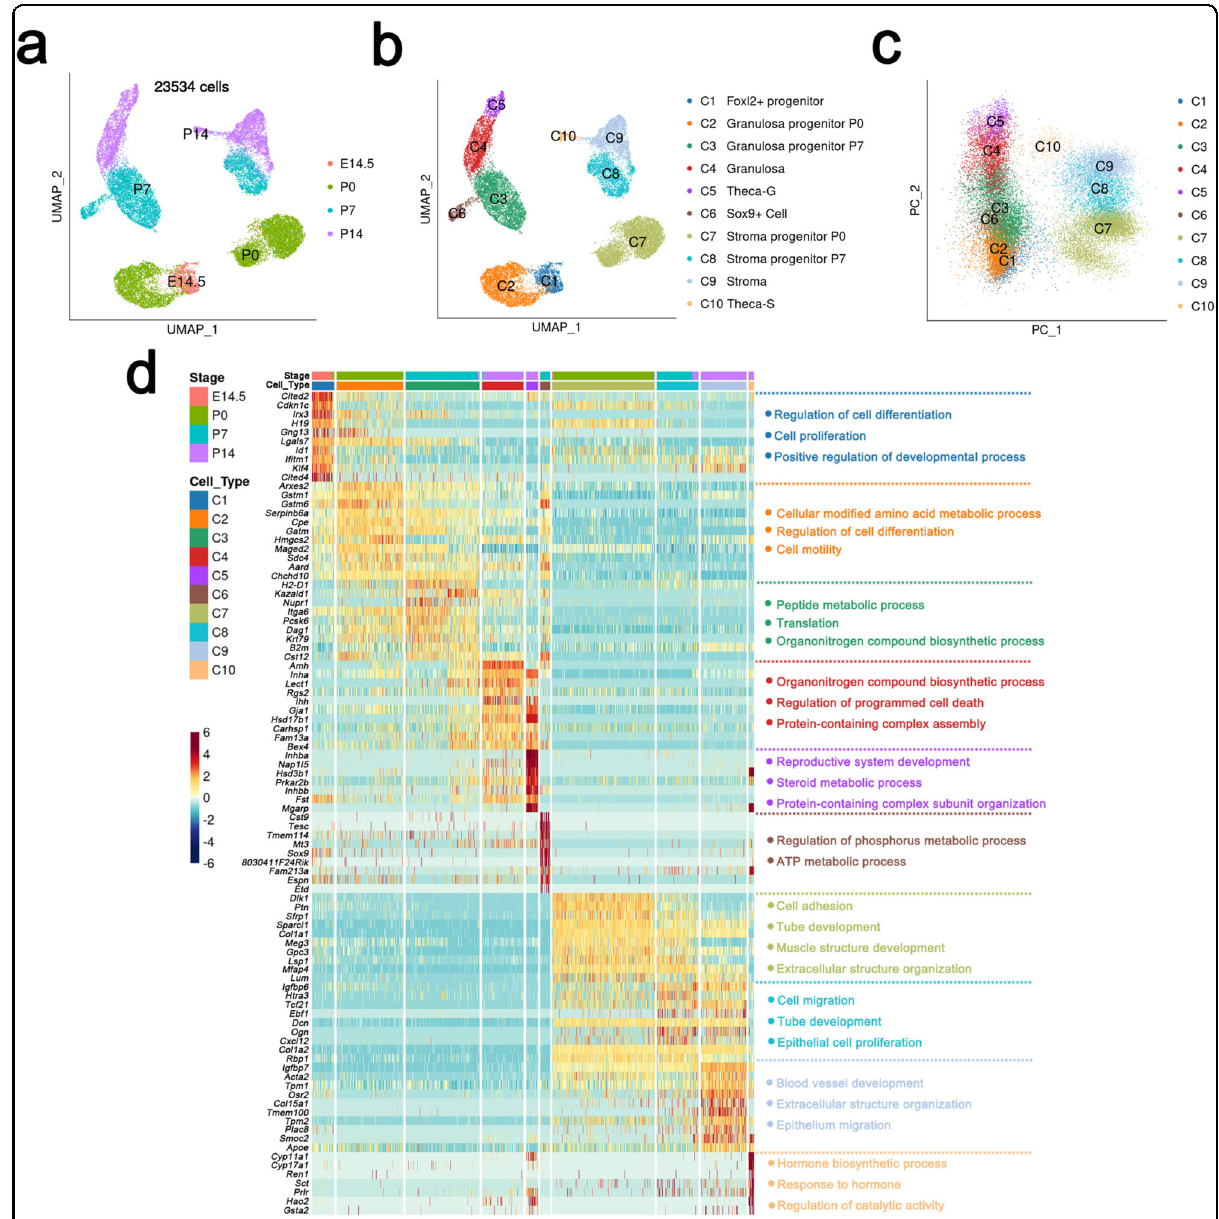
Fig. 3 Classi fi cation and Identi fi cation of progeny of Foxl2 -expressing cells during ovarian development. a Expression matrix-based Uniform manifold approximation and projection (UMAP) plot showed the fi ltered FOXL2 + progenitor-derived cells (23,534 cells). Cells were colored by time points of sample collection. b UMAP plot as shown in a , with cells colored by cell clusters after unsupervised clustering. c Expression matrix-based principle component (PC) plot of cell clusters in b . d Left, heatmap showing top ten highly expressed genes for each cell cluster shown in b , red color corresponded to high expression levels; blue color corresponded to low expression levels. Right, representative enriched items of gene ontology (GO) biological process for the genes highly expressed in corresponding cell